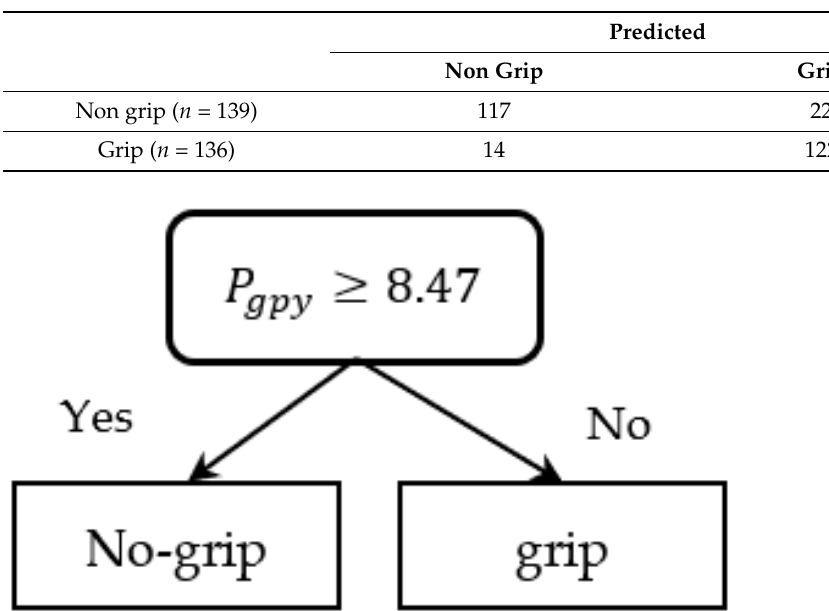
Table 1. Confusion matrix for the decision tree model in the case of Environment 1.